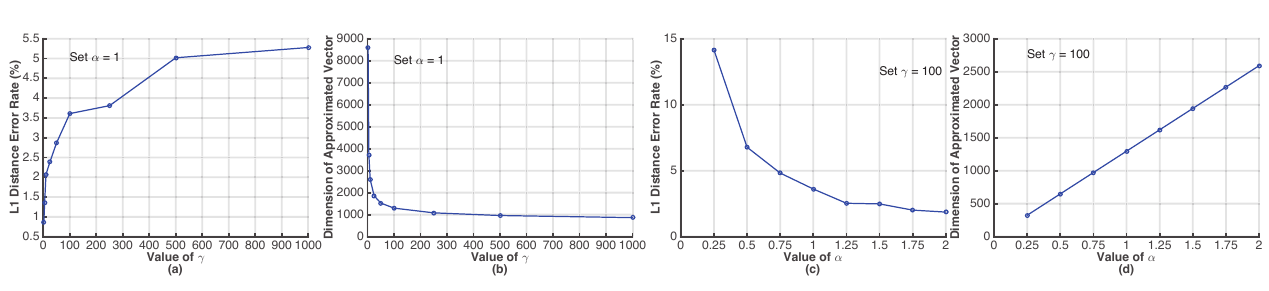
Figure 5. Error rate of Approximation and Dimension of Approximated Vector ( P CA − 32